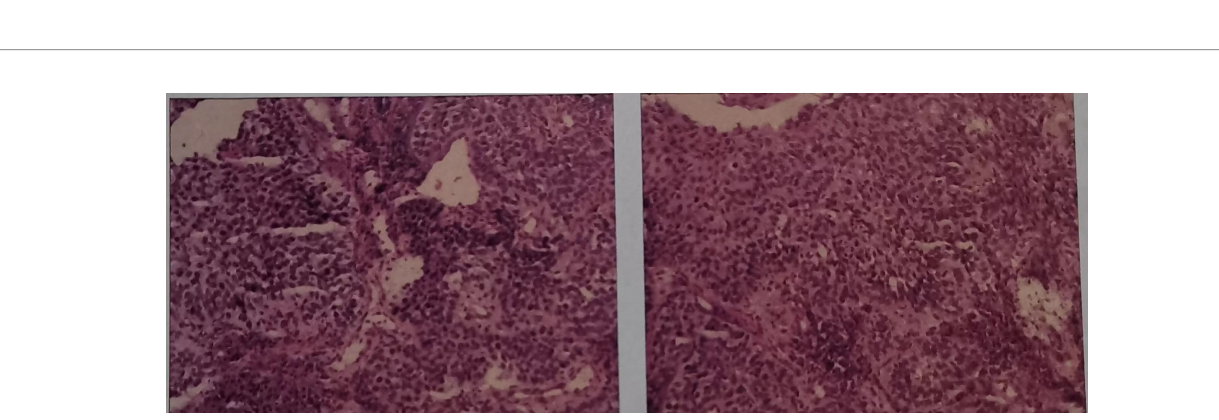
FIGURE 2 | Haematoxylin and eosin-stained sections of low-differentiated squamous cell carcinoma in the esophagus (ESCC). (On July 16, 2020, tissue biopsy specimens were taken from the lower esophagus under